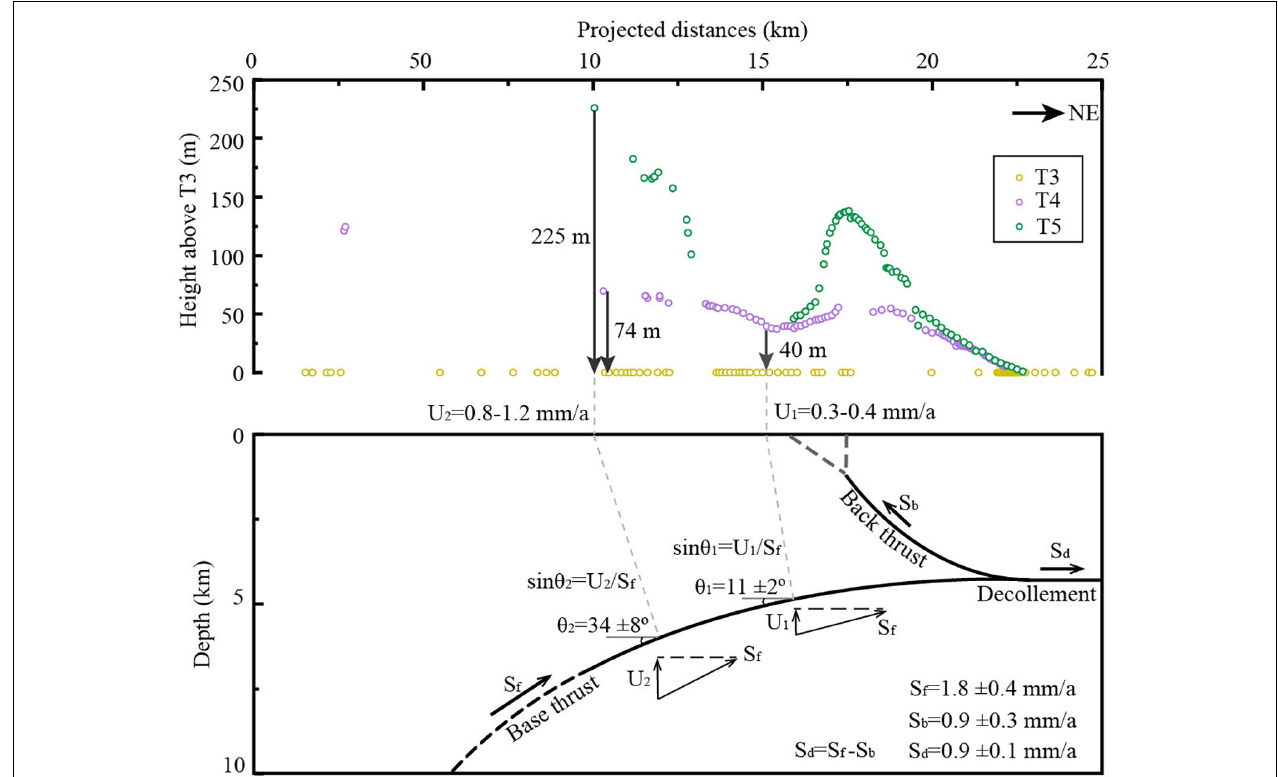
FIGURE 6 | The overall geometry for the subsurface thrust fault. In calculating the fault dip, we assume that the river incision equal to the rock uplift. S f = the full fault slip rate along the base thrust, S b = the fault slip rate along the back thrust, S d = the fault slip rate to the north of the back thrust, U = vertical component of the dip-slip rate or uplift rate, θ = the local fault dip angle.